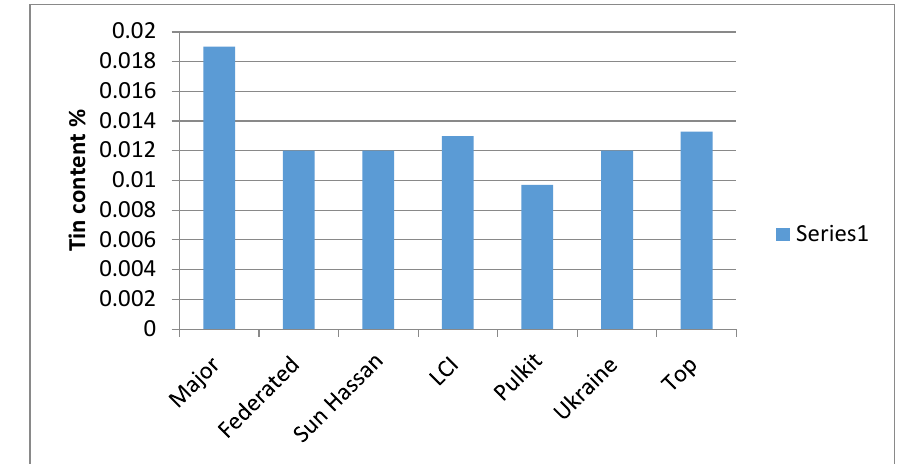
Fig. 10. Tin (Sn) content in the steel specimens.